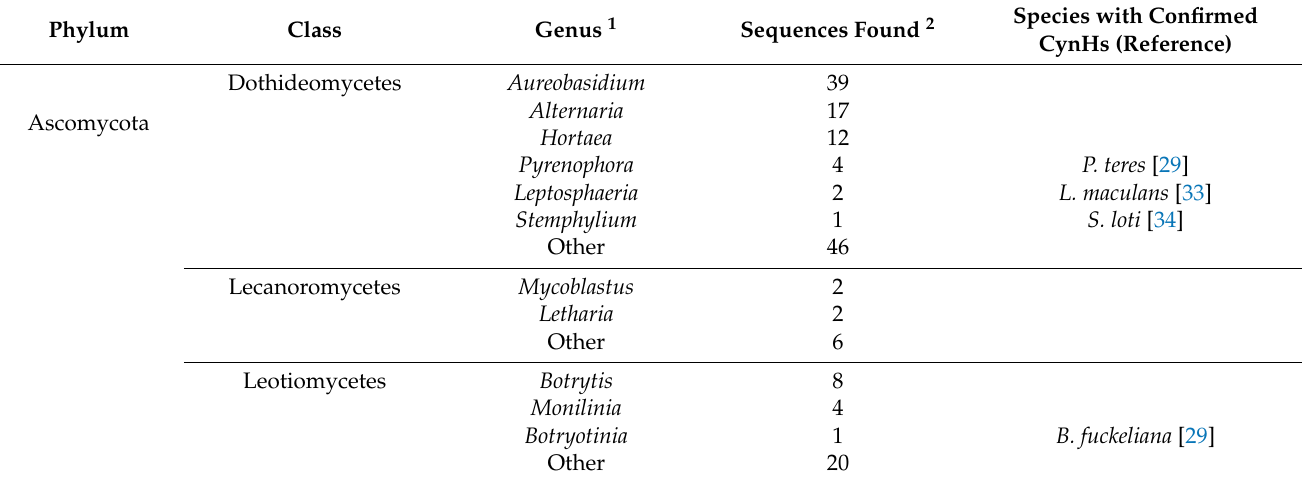
Table 2. Cyanide hydratases (CynHs) identified in